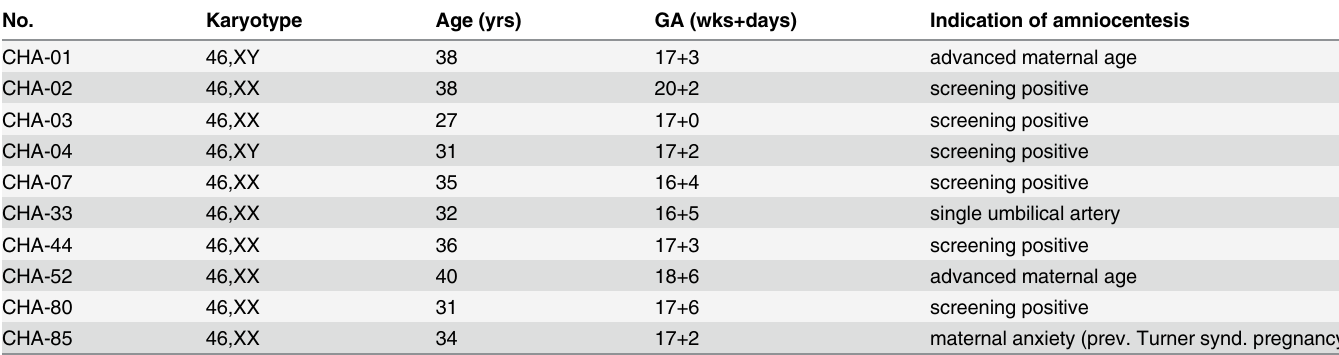
Table 1. Clinical information of the participants in this